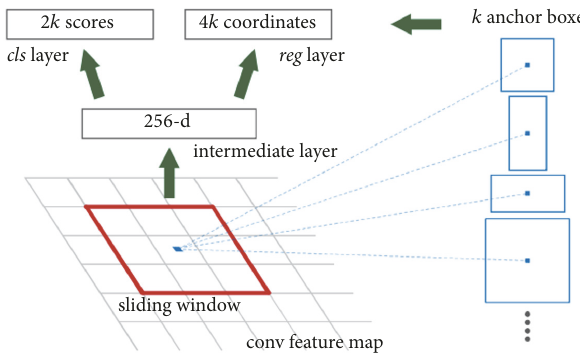
Figure 2: RPN network structure.